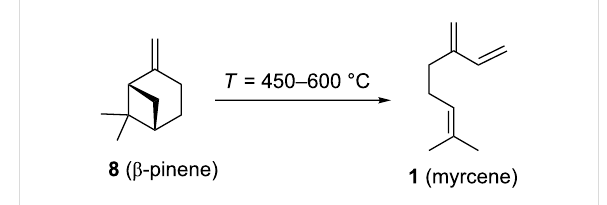
characteristic odour” was formed, later named pseudoionone ( 29 , Scheme 1). It turned out not to be suited for further investi- gations. However, after cleaning the glassware with sulfuric acid, a distinctive scent of violets was noted which later was linked to ionone ( 30 ) being created in the acidic medium. Thus, the category of synthetic ionone ( 30 ) and woody smelling com- pounds was born in 1893 and investigated further in the following years